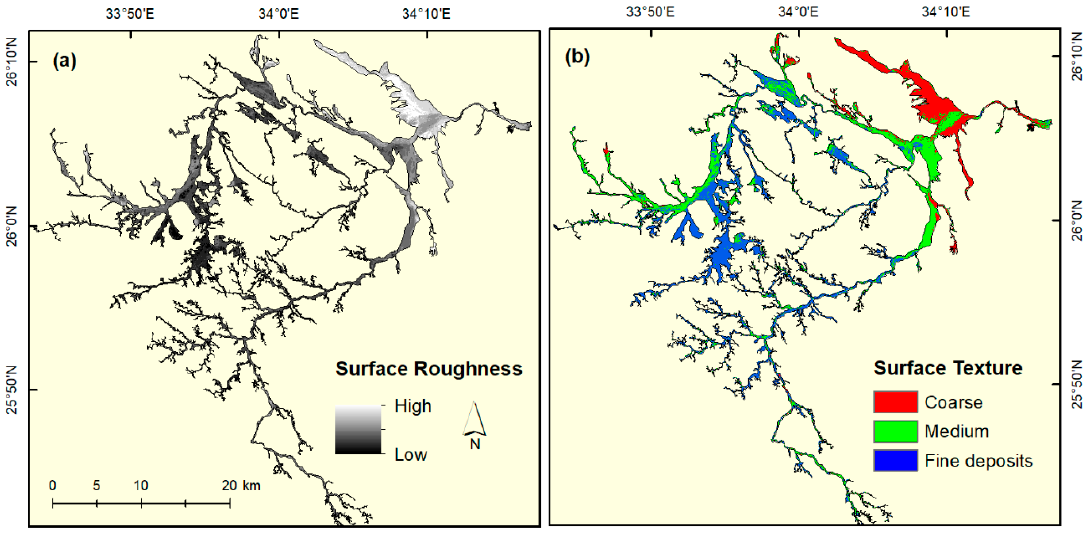
Figure 4. The alluvial deposits of the main channel course of Wadi El-Ambagi (the main channel course was mapped through on-screen digitizing from Google Earth Pro). ( a ) ALOS-PALSAR illustrating different surface roughness properties of wadi course, and ( b ) Surface textures of wadi alluvial deposits.